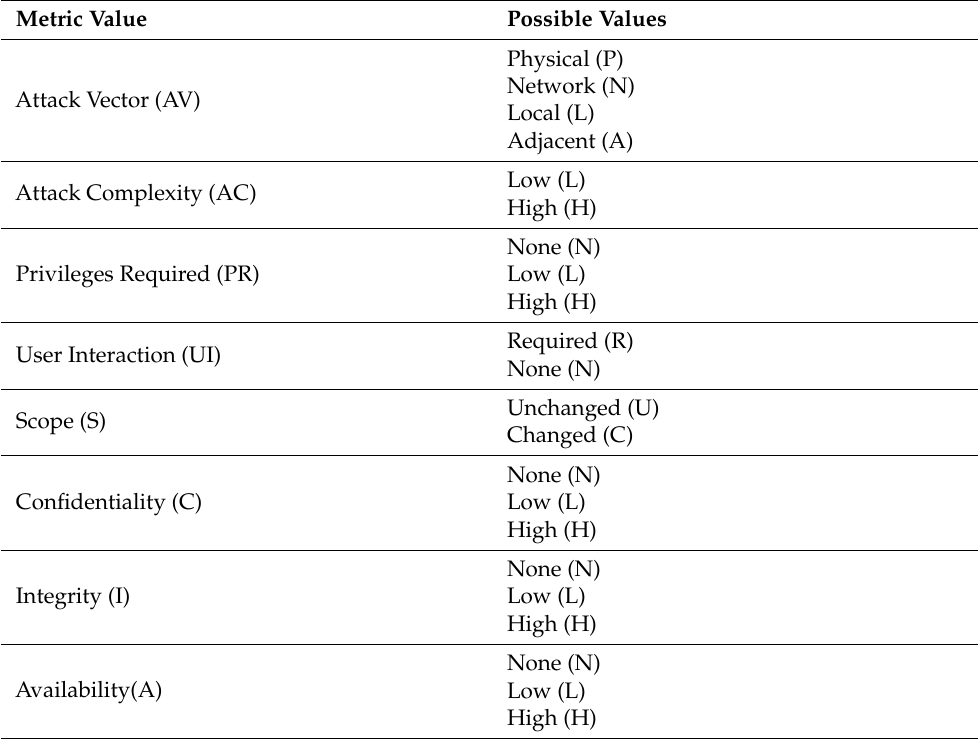
Table 3. Possible values for the base metric group of the CVSS v3.1